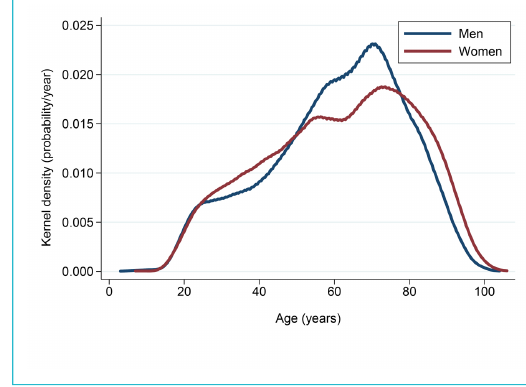
Figure S1: Age distribution of the study population by gender. The distribution of the 25 721 patients (13 912 males and 11 809 females) included in the analysis according to age is depicted as kernel density.